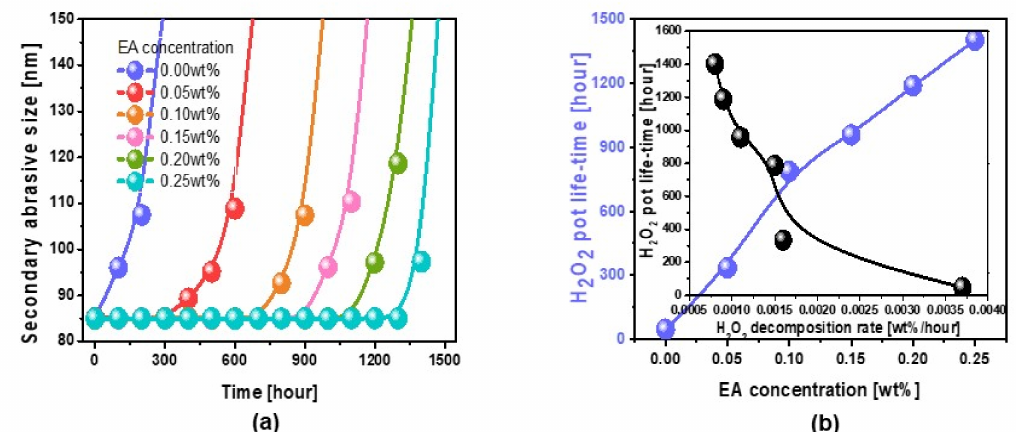
Figure 3. Effect of scavenger (i.e., EA) on the ZrO 2 abrasive stability in W-film surface slurries mixed with 1.5 wt% H 2 O 2 . ( a ) Secondary abrasive size vs. the progress time after mixing H 2 O 2 into the W-film surface slurries, depending on the scavenger (i.e., EA) concentration. ( b ) H 2 O 2 pot lifetime depending on the scavenger concentration. The inset represents the correlation between H 2 O 2 pot lifetime and H 2 O 2 decomposition